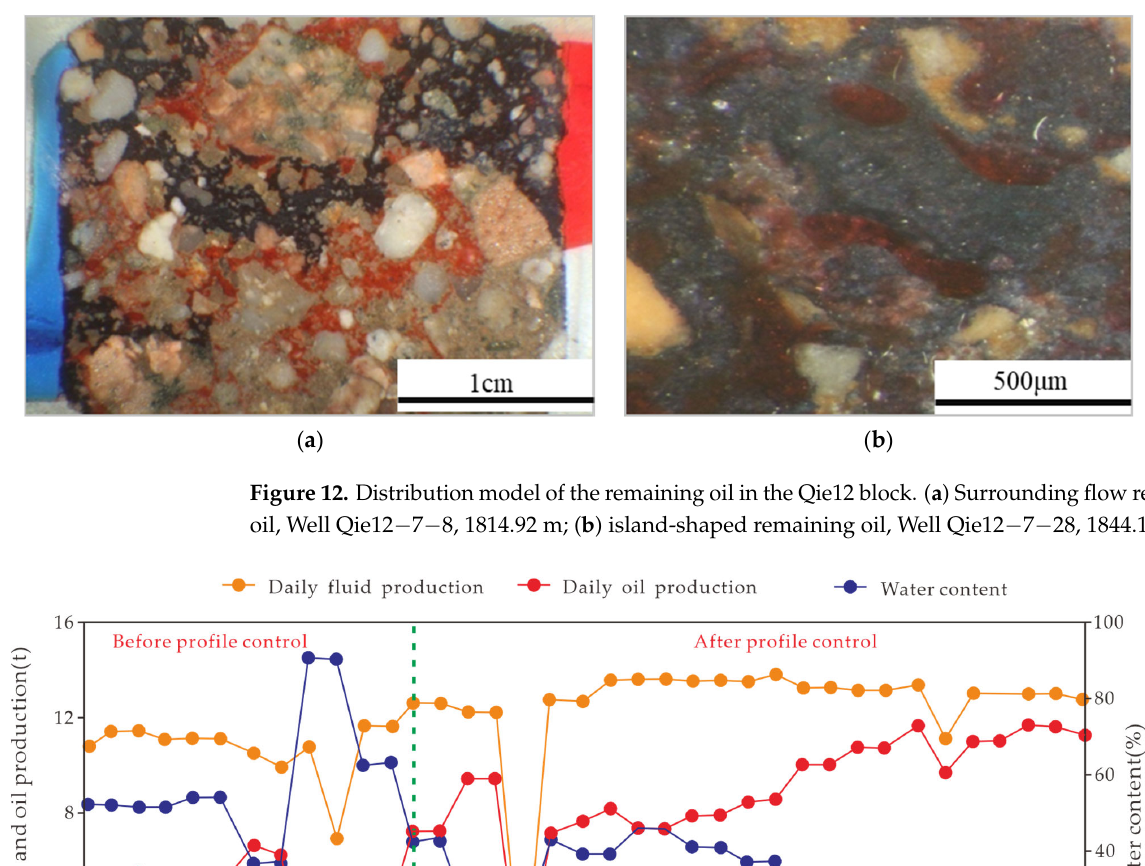
Figure 12. Distribution model of the remaining oil in the Qie12 block. ( a ) Surrounding flow remain ‐ ing oil, Well Qie12 − 7 − 8, 1814.92 m; ( b ) island ‐ shaped remaining oil, Well Qie12 − 7 − 28, 1844.12 m.